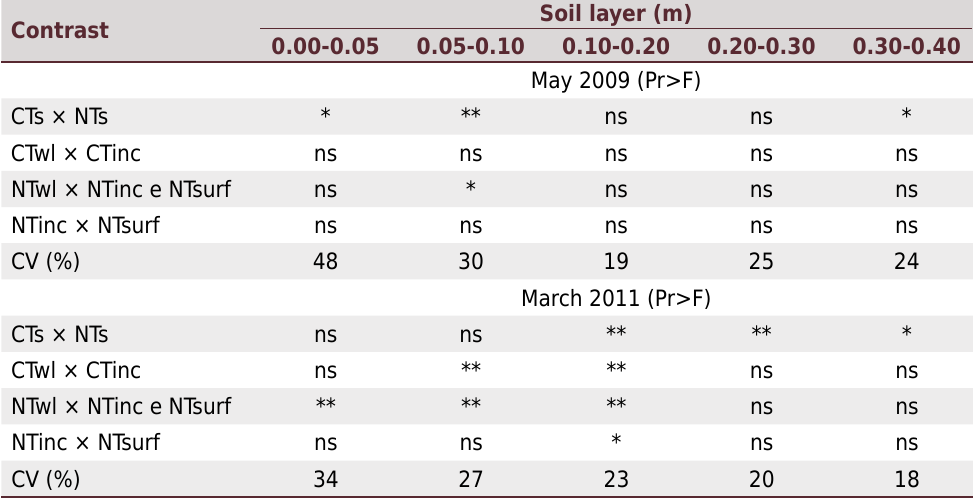
Table 2. Contrasts of combinations of tillage systems and liming methods for penetration resistance, in May 2009 and March 2011, in a Latossolo Bruno Alumínico típico (Hapludox) Contrast